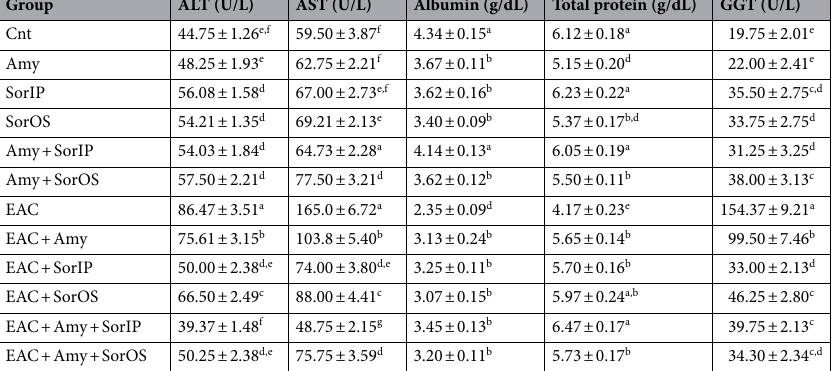
Table 2. Liver function parameters in EAC-bearing mice after treatment with amygdalin and/or sorafenib. Data were presented as means ± SEM. Small (a–e) letters showed the marked change at P ≤ 0.05. The significant were expressed by dissimilar letters in the same